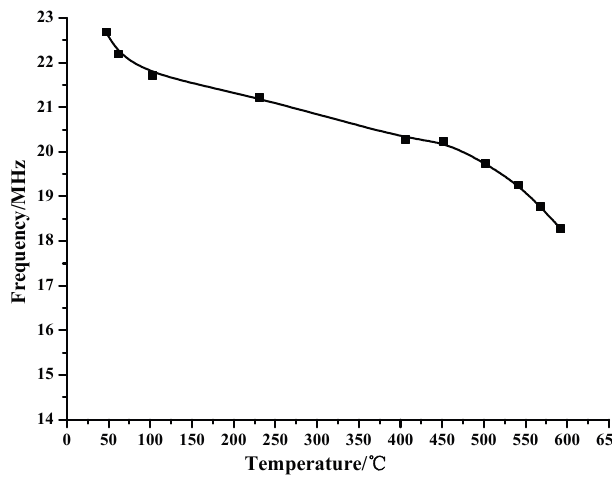
Figure 10. Measured frequency versus